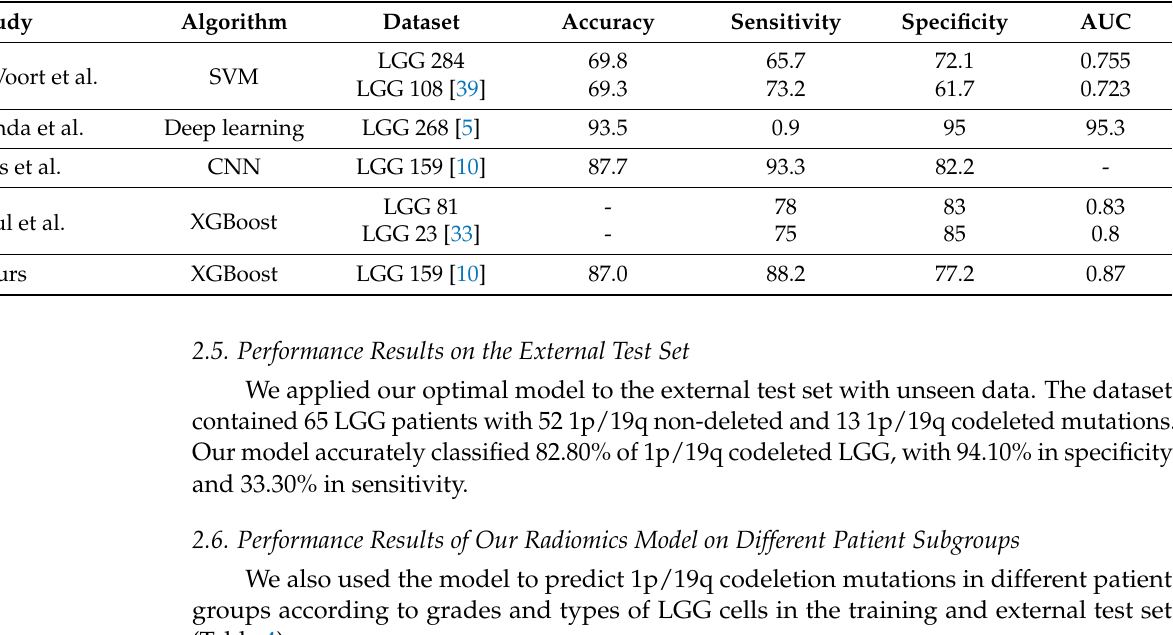
Table 3. Performance comparisons between our XGBoost-7 and other typical models.